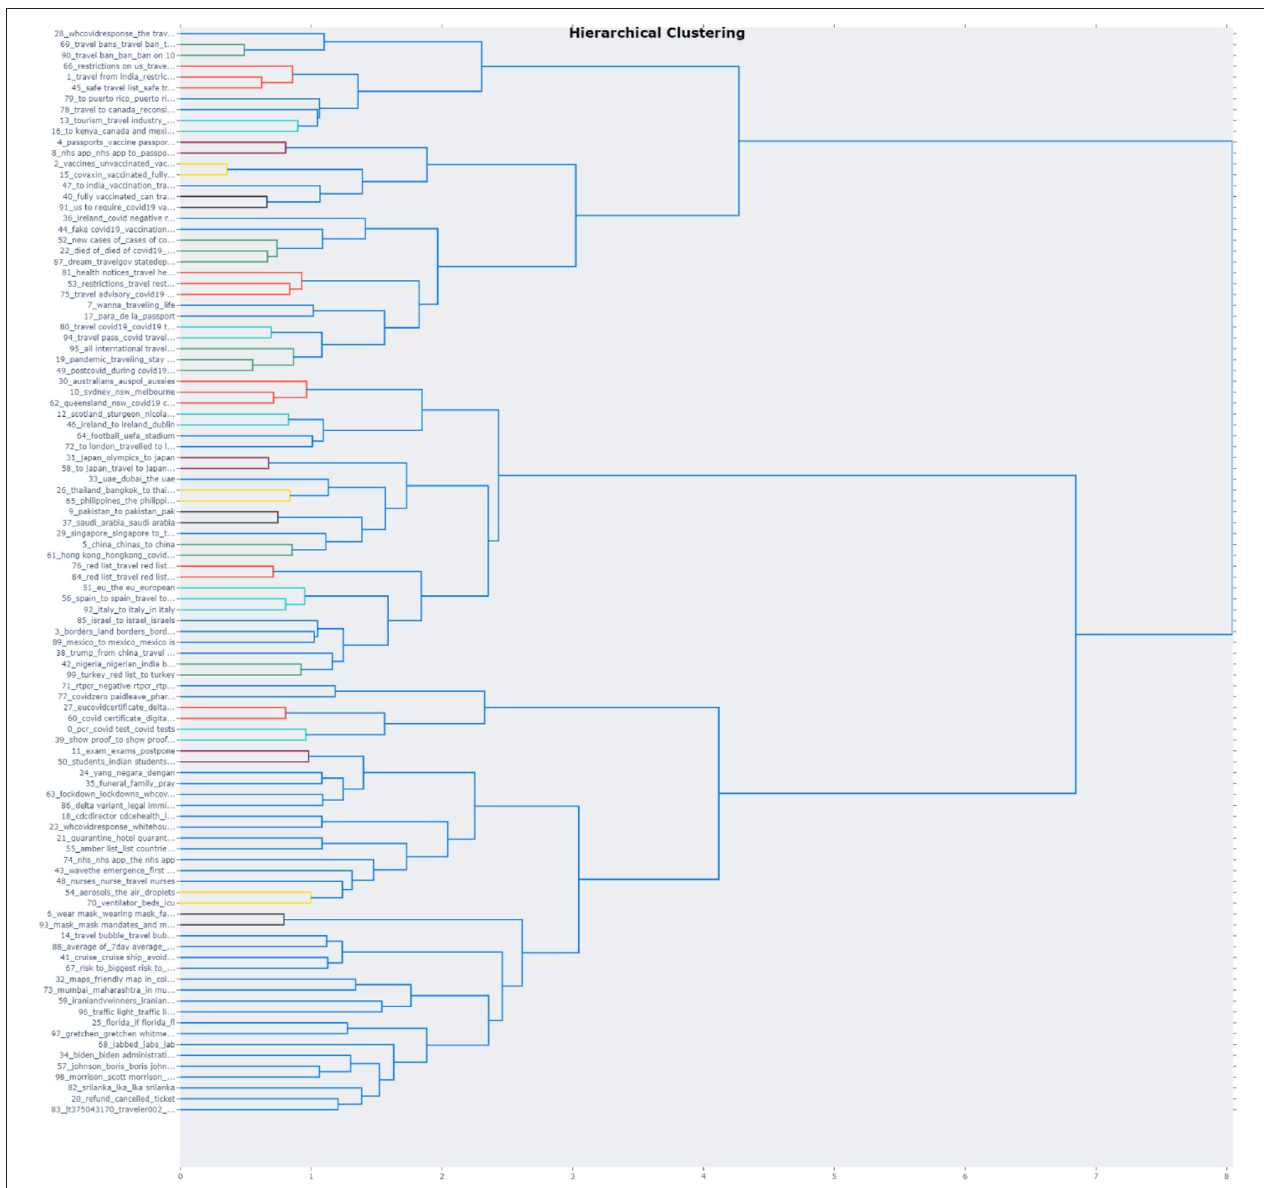
FIGURE 5 | Hierarchical reduction in